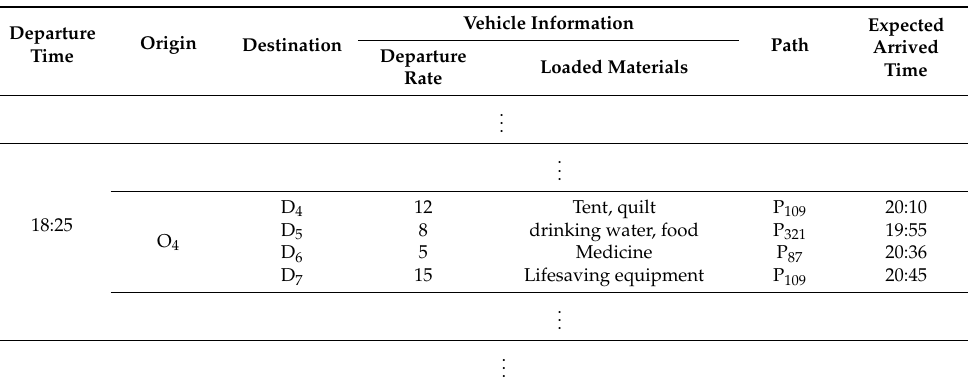
Table 3. An example of a vehicle dispatching and routing Figure 9. The utilized road in the emergency network.